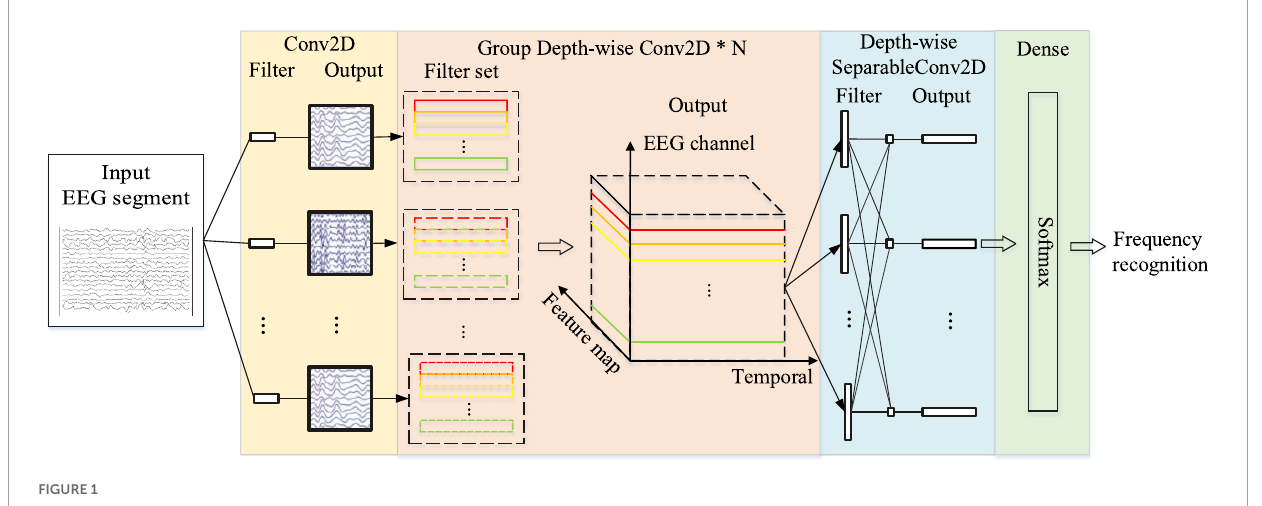
FIGURE1 The architecture of the GDNet-EEG model for SSVEP stimulation frequency recognition.